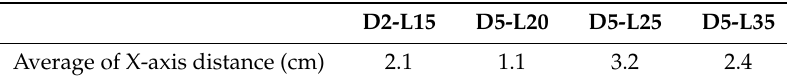
Table 2. Summary of Figure